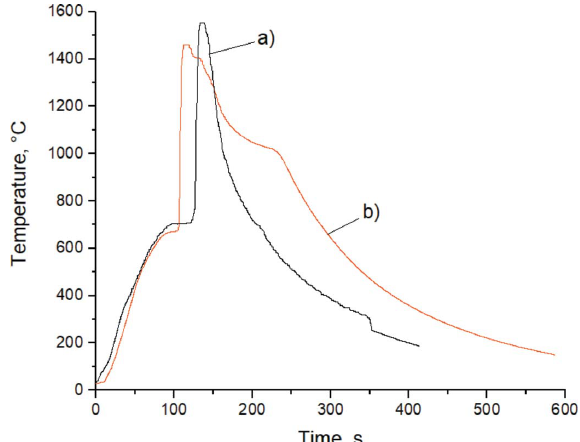
Figure 4 Thermograms of high-temperature synthesis of Ti + Al precursors (MA, t = 7 min) followed by their cladding (deposition time (cid:2) = 40 min): ( a ) with shutdown; ( b ) with system annealing.